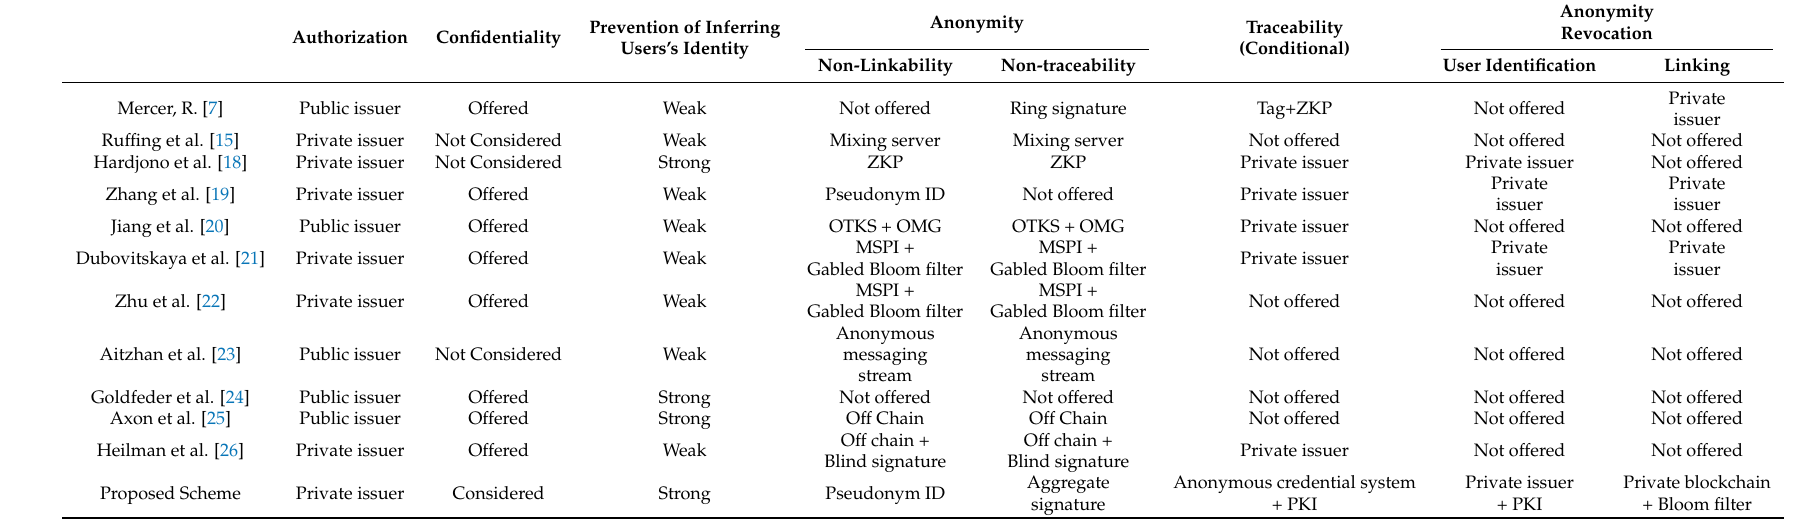
Table 6. A comparison of features of schemes for privacy in